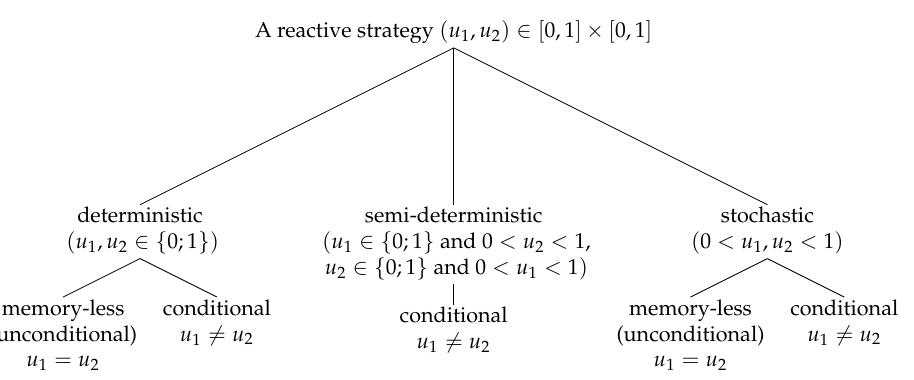
Figure 1. A possible classification of reactive